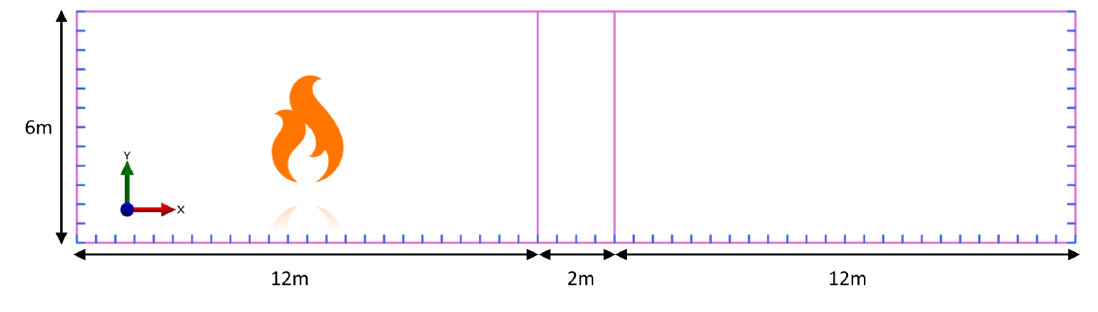
Figure 1. Section of the reference tunnel and dimensions (lining axis positions). The blue lines are springs modelling the soil interaction.